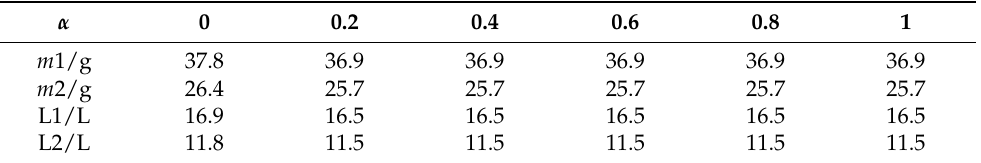
Table 9. Energy consumption table corresponding to the compensable coefficients of different motors underworking condition A in bench test.